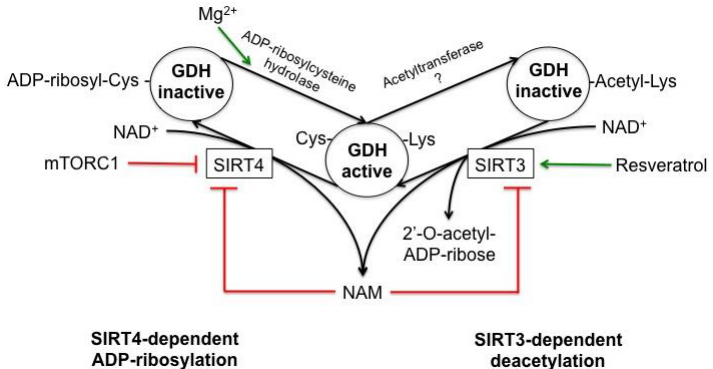
Figure 6. Schematic representation of GDH post-translational modifications regulated by sirtuins 3 and 4. ADP-ribosylation and acetylation are shown on the left and right, respectively. NAD + -dependent ADP-ribosylation of GDH is catalyzed by sirtuin 4 (SIRT4). Nicotinamide (NAM) is the second reaction product. As a result of the modification of a cysteine residue, GDH loses its catalytic activity. GDH deribosylation is catalyzed by ADP-ribosylcysteine hydrolase, which requires magnesium ion as a cofactor (indicated by a green arrow). The enzyme catalyzing acetyl-CoA-dependent GDH acetylation has not been identified, which is depicted as “Acetyltransferase ?”. GDH deacetylation is catalyzed by NAD + -dependent mitochondrial deacetylase, sirtuin 3 (SIRT3). NAD + and acetylated GDH are the substrates for SIRT3 in the reaction releasing 2′- O -acetyl-ADP-ribose, NAM and deacylated GDH. The product of the sirtuin-dependent reactions, NAM, inhibits sirtuins. SIRT4 activity can be repressed via mTORC1 [122], and SIRT3 is up-regulated by resveratrol [123]. Red arrows indicate inhibition, whereas the green arrows represent activation.